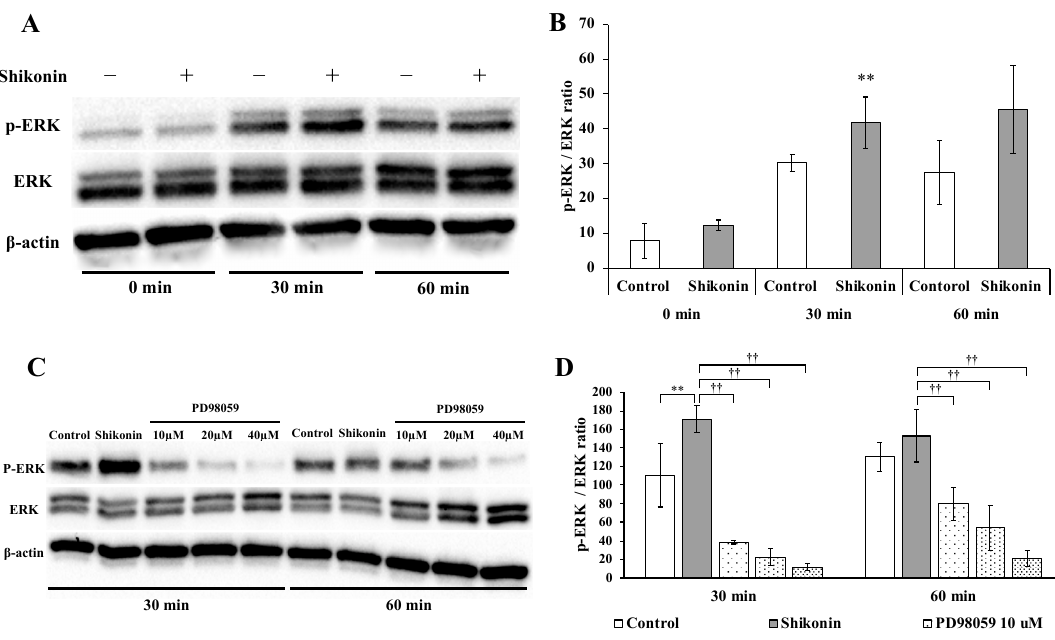
Figure 4. Effect of shikonin on the activation of the MAPK signaling pathway component ERK 1/2. Human gingival fibroblasts were cultured in medium without (control) or with 1 μ M shikonin for 0, 30, or 60 min. ( A ) Protein expression was evaluated by immunoblotting analysis. ( B , D ) The quantification was performed using image analysis software (** p < 0.01, control vs. 1 μ M shikonin; †† p < 0.01, 1 μ M shikonin vs. 1 μ M shikonin + PD98059 (10 μ M, 20 μ M and 40 μ M). ( C ) Effect of PD98059 (ERK 1/2 inhibitor) on shikonin-stimulated activation of the MAPK signaling pathway.